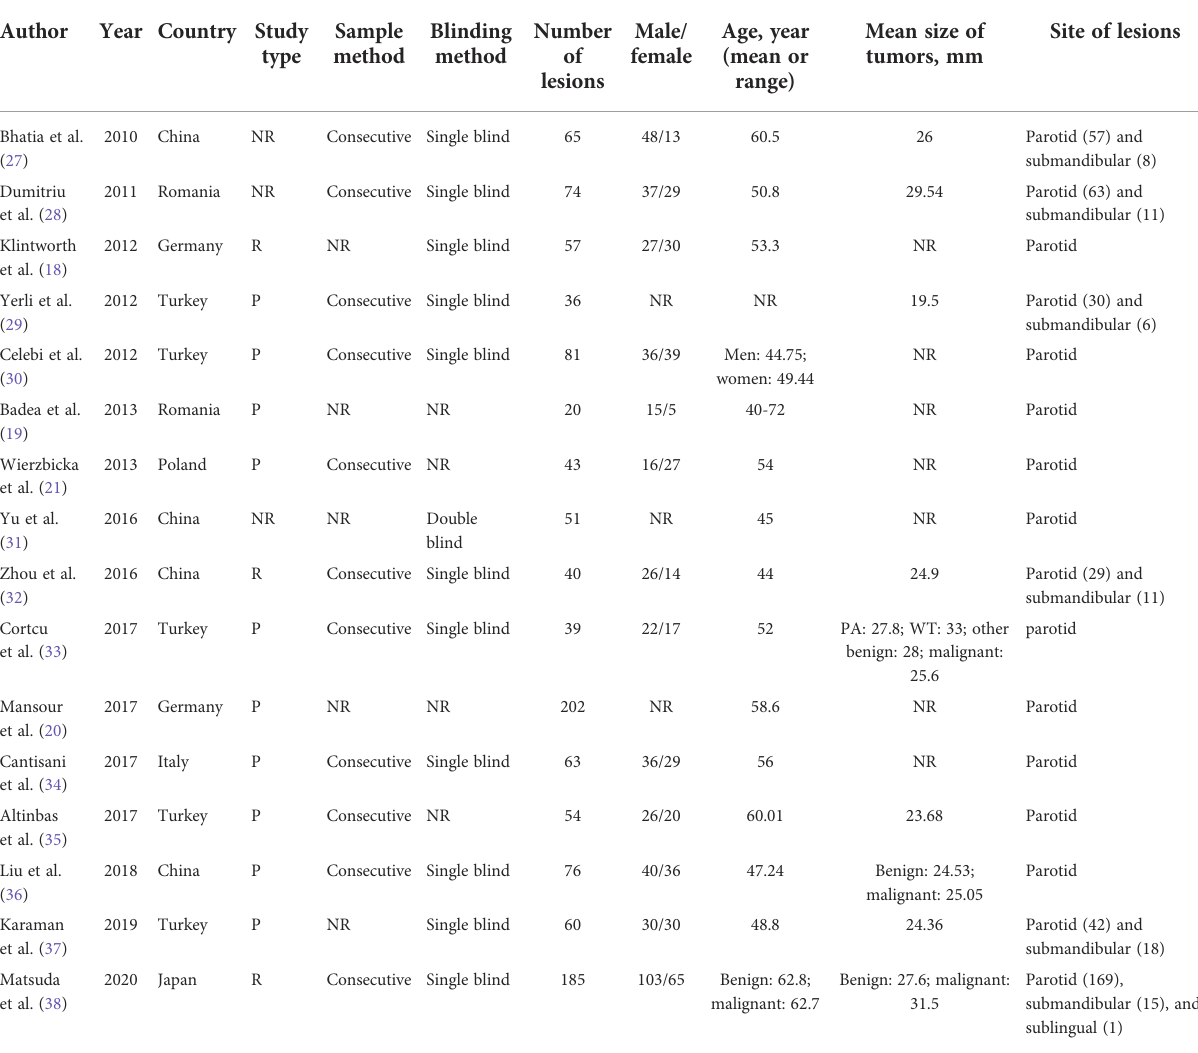
TABLE 1 Primary data extracted from the included studies for